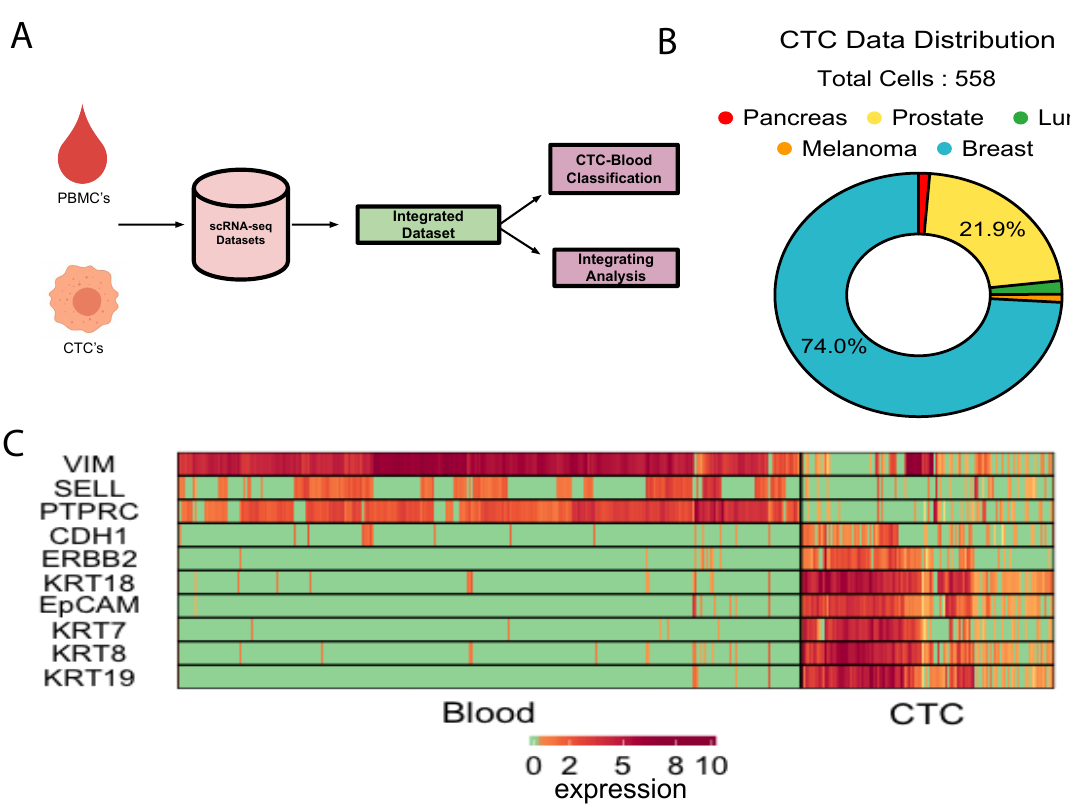
Figure 1. Integrative analysis of CTC transcriptomes: ( A )Schematic of study. ( B ) Cancer types represented by the integrated CTC population. ( C ) Expression of canonical epithelial and immune cell markers in CTCs and the PBMCs under